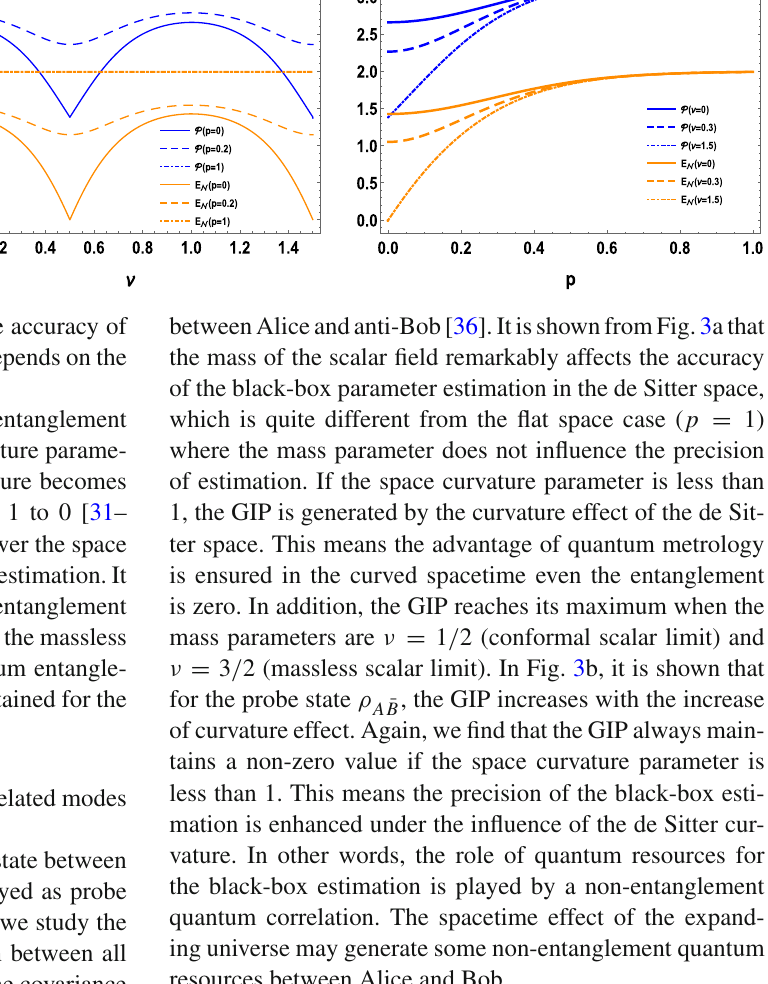
Fig. 2 a The GIP and quantum entanglement between Alice and Bob versus the mass parameter ν . b The evolution of the GIP and quantum entanglement versus the space curvature parameter p . The initial squeezing parameter is fixed